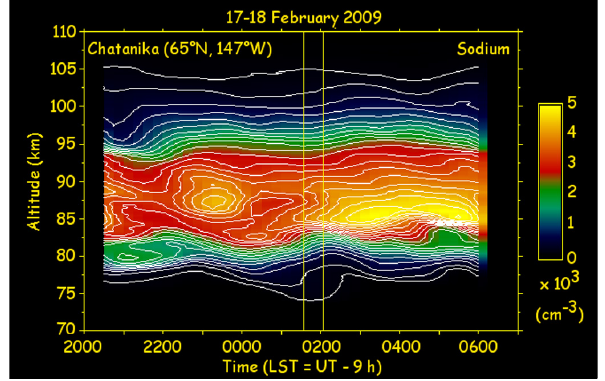
Fig. 4. Sodium concentration profile measured by resonance li- dar at Chatanika, Alaska on the night of 17–18 February 2009. The nightly average sodium concentration measured over the in- terval 20:35–06:00LST (05:35–15:00UT, thick dashed line) and the sodium profile measured over the 15min interval centered at 02:00LST (11:00UT, thin solid line) are plotted. The profiles are smoothed with a 1km Parzen